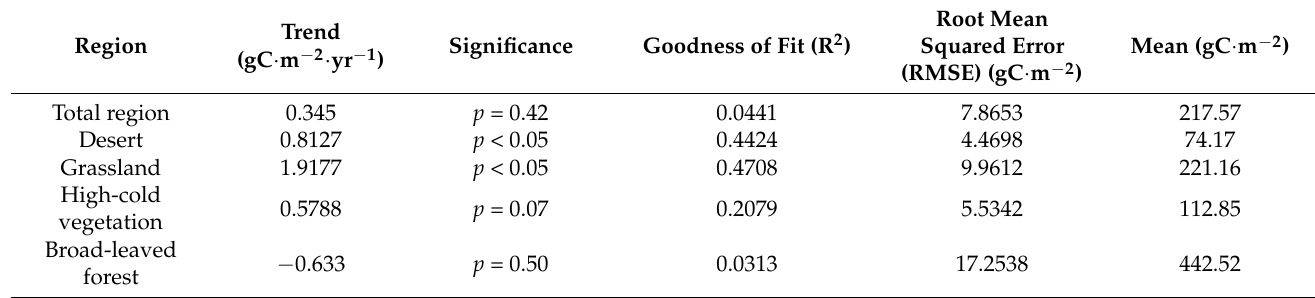
Figure 3. The average net primary productivity (NPP) in different vegetation regionalization from 2001 to 2017. Table 1. NPP mean value and trend analysis results of each